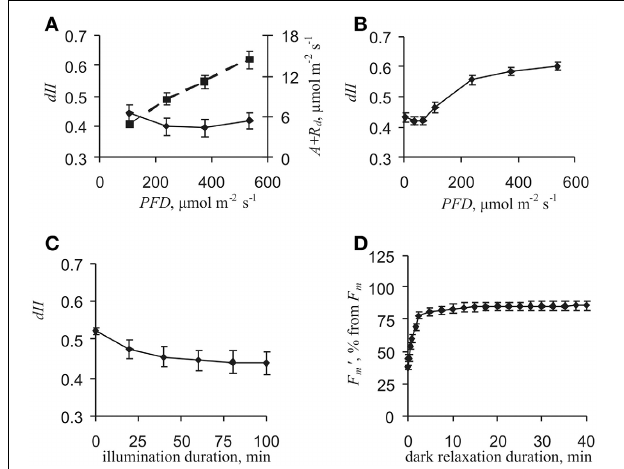
FIGURE 2 | Dependencies of photosynthetic parameters on light intensity and duration of illumination by actinic light and darkness. (A) dependencies of dII and A + R d on light intensity after 1h control actinic light. Values for dII calculated using Equation (4) under external CO 2 concentration of 2000ppm ( n = 7). (B) dependence of dII on light intensity after 1h control actinic light. Value of dII calculated using equation (7) ( n = 6). (C) dependence of dII on duration of control actinic light illumination. Value of dII calculated using Equation (7); actinic light intensity, 47 μ mol · m − 2 · s − 1 ( n = 5). (D) dependence of F m ’ on duration of darkness after actinic light illumination for 1h.